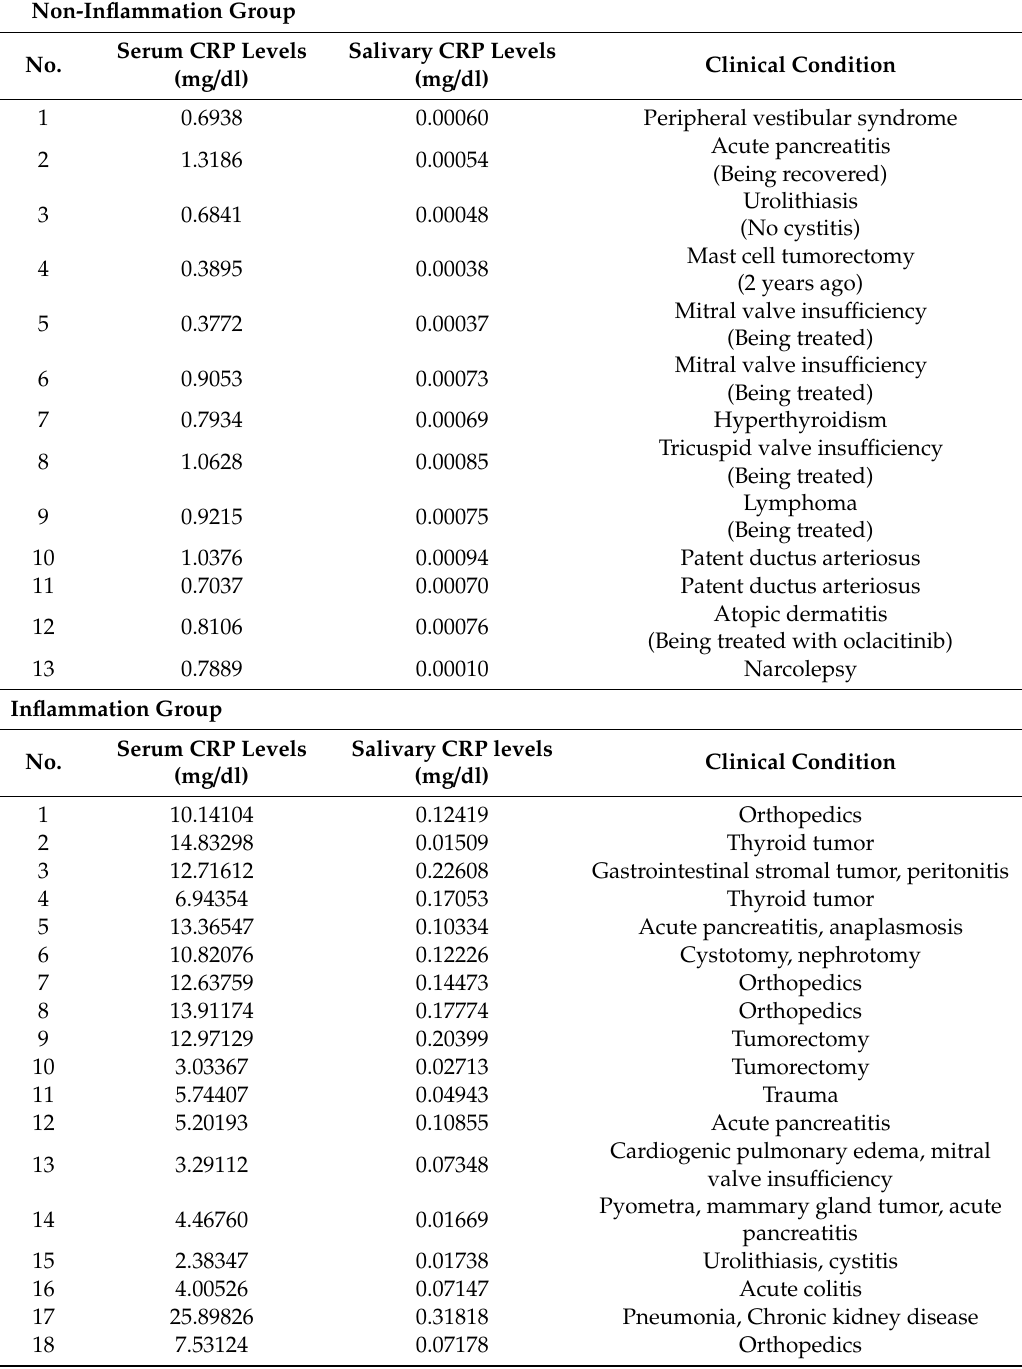
Table 1. Measured C-reactive protein (CRP) levels in the serum and saliva samples and the clinical conditions of the inflammation group ( n = 19) and non-inflammation group ( n =